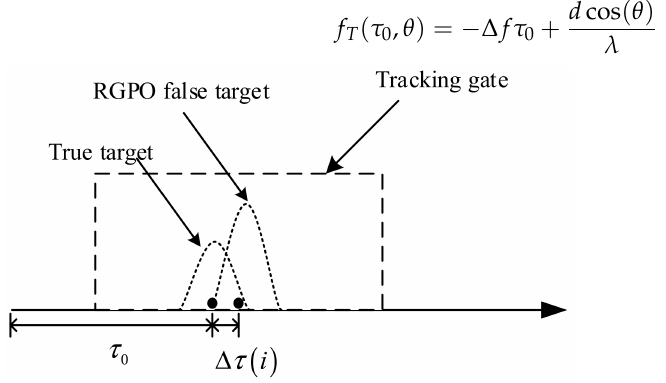
Figure 1. Schematic of RGPO false